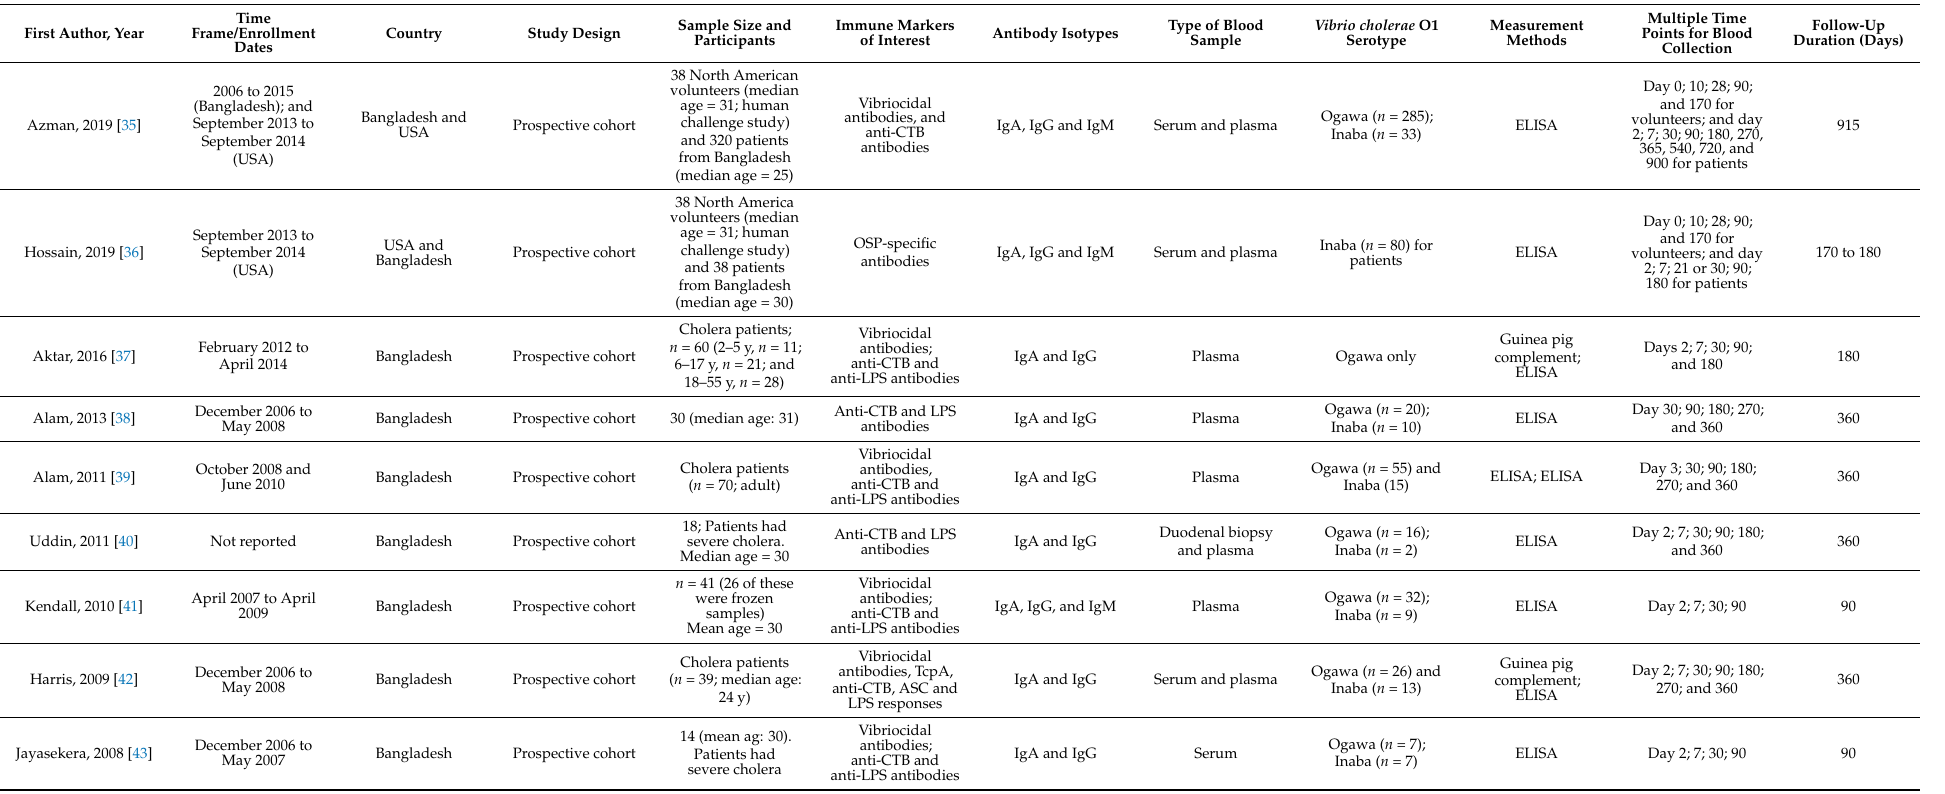
Table A1. Characteristics of included studies